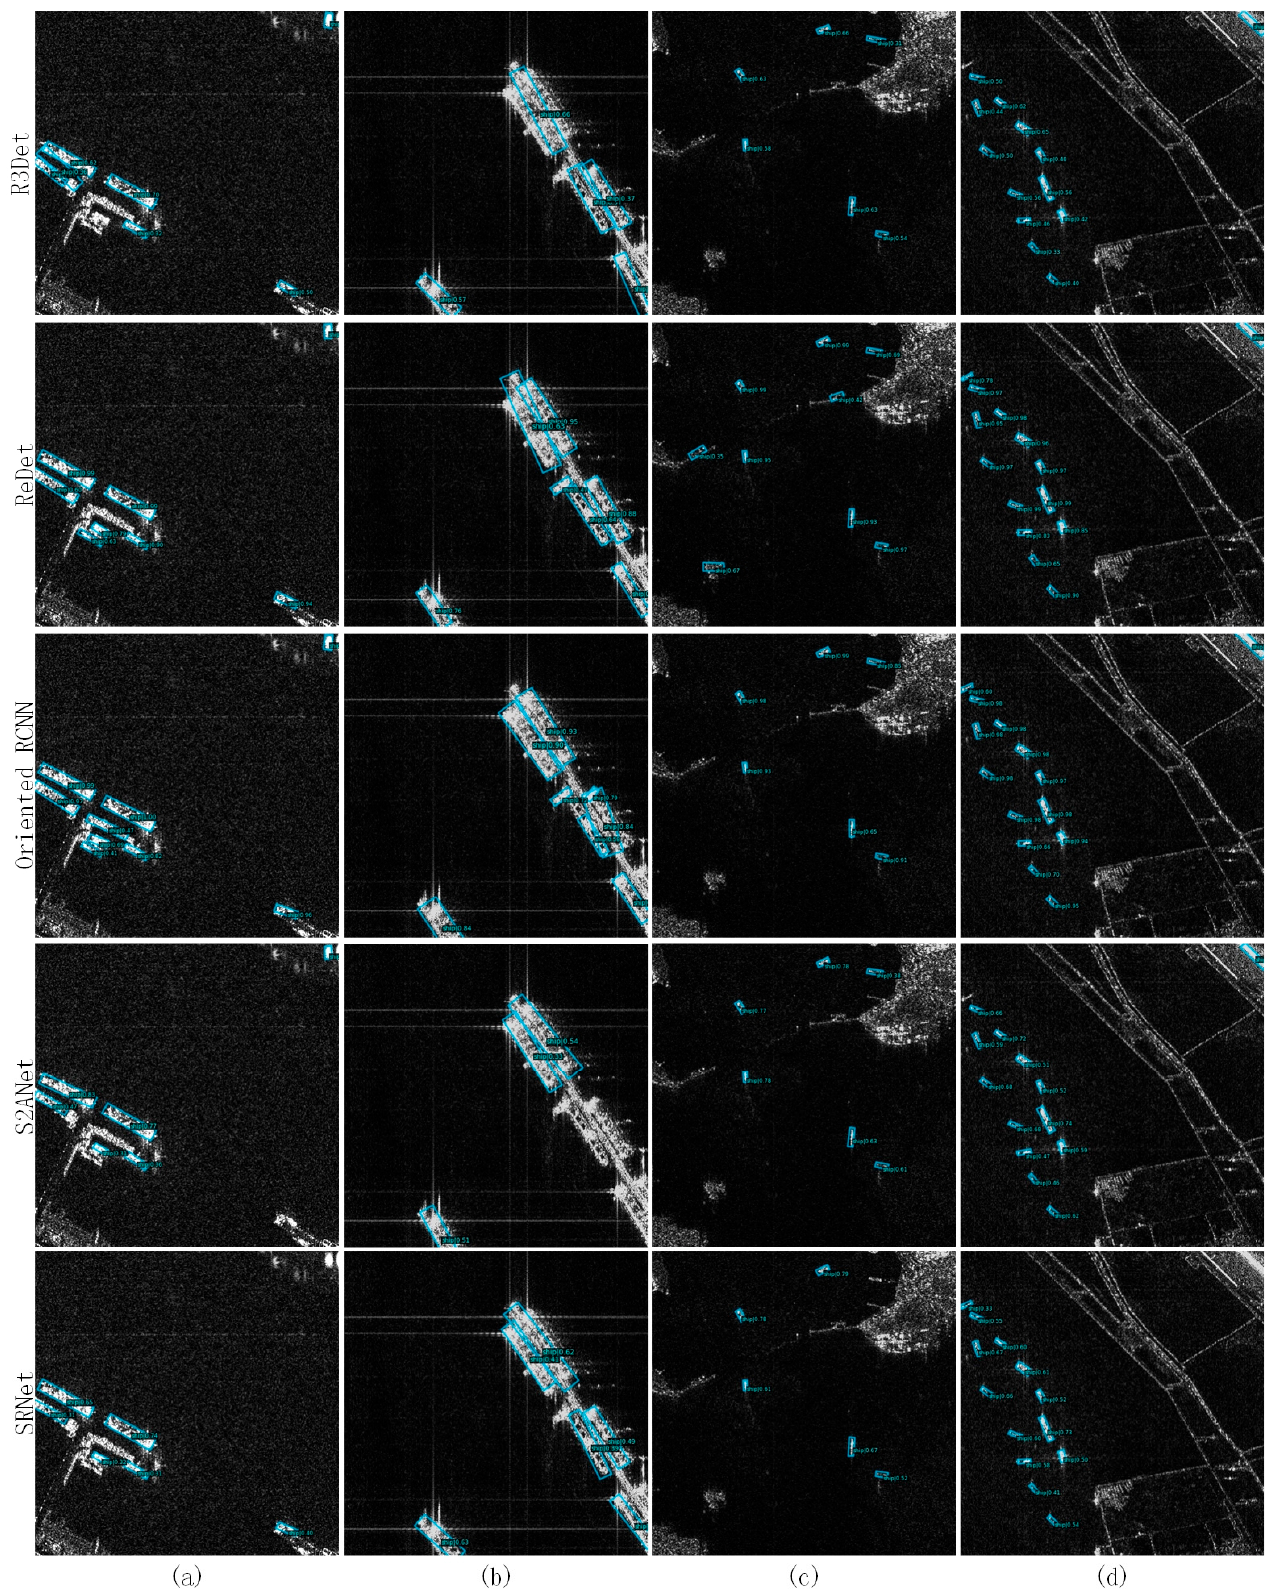
Figure 12. Four visualization illustration images of different comparison networks for rotated object detection on the RSDD dataset. ( a ) The scene of the ships berthing on one side of a dock. ( b ) The scene of the ships berthing on both sides of a dock. ( c , d ) The scene of ships sailing in the water